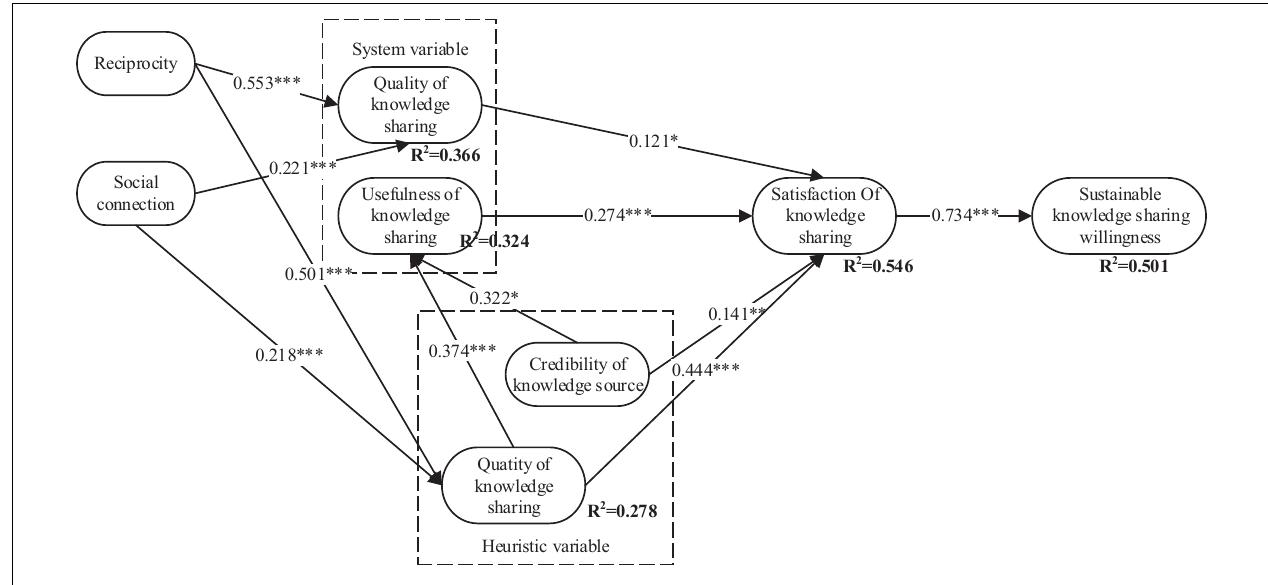
FIGURE 3 | Model results. * p < 0.05, ** p < 0.01, *** p <